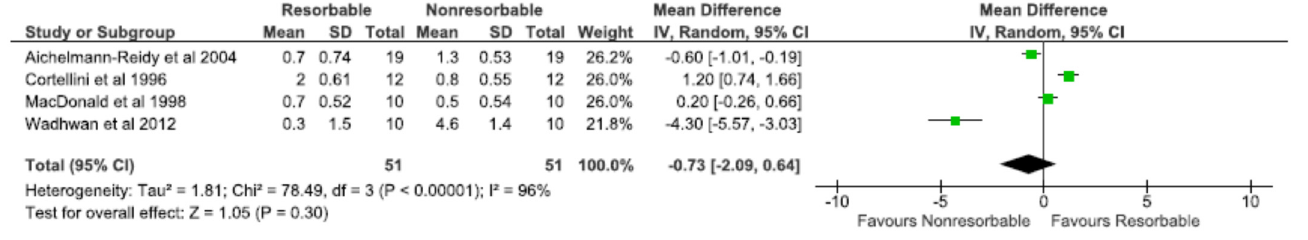
Figure 8. Meta-analysis of gingival recession (GRC) at all intervals (6–12 months).